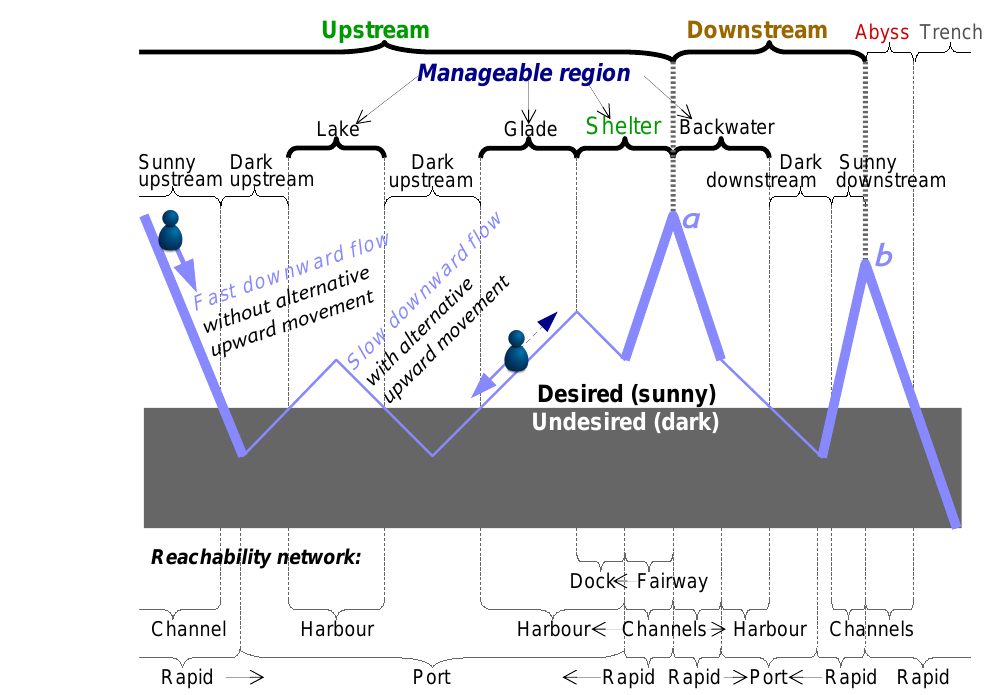
Figure B1. A system moves along the blue line: downward by default (pale-blue arrows), but in some regions management can move it in the opposite direction (dark-blue arrow) in order to avoid the undesired “dark” region. Shelters, manageable region, upstream, and downstream (boldface, Sect. 2.2) and other regions from the main cascade (top line, Sect. 2.3). Regions from the finer manageable partition